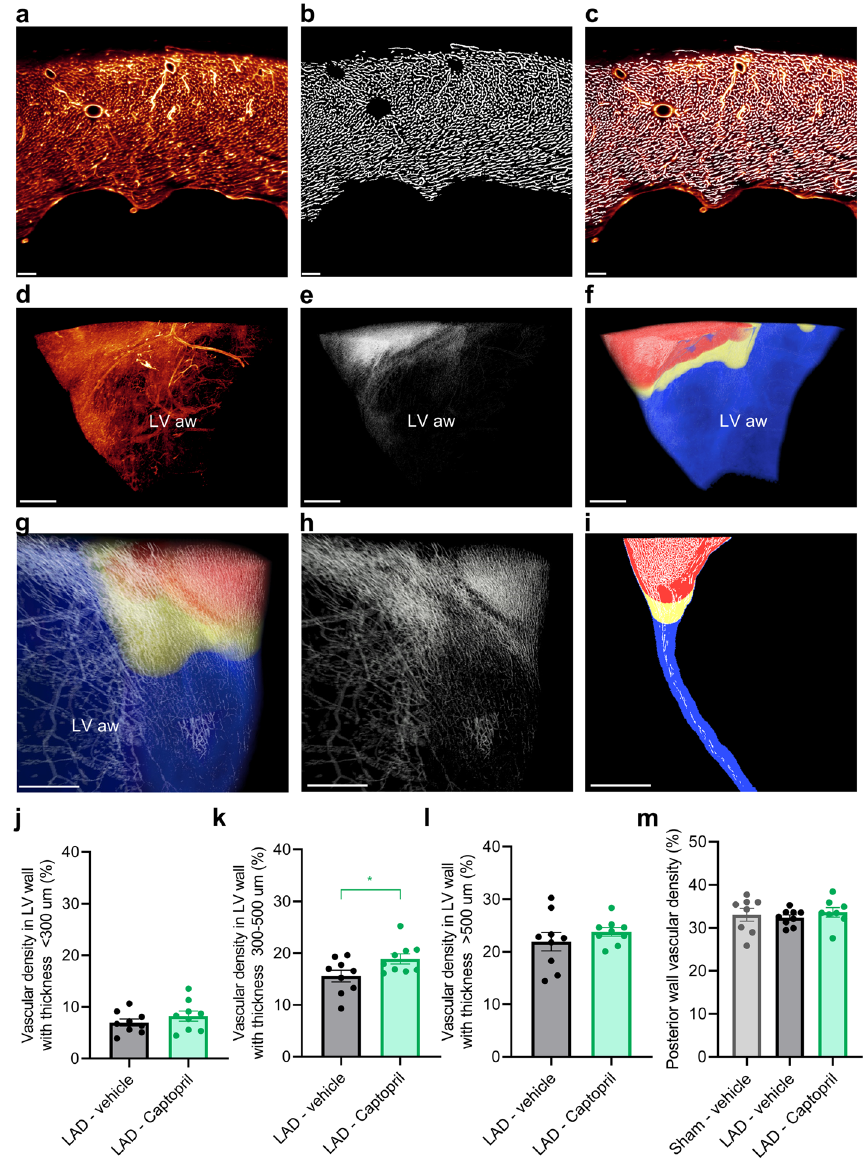
Figure 5. Captopril improves vascularization in the border zone. ( a ) 2D view of lectin perfused vasculature in the left ventricle (LV) wall. ( b ) Automatically segmented blood vessels in the same image. ( c ) Lectin perfused vasculature and overlay with automated detection (in white) of capillaries and arterioles. ( d ) 3D view of lectin perfused vasculature in the LV anterior wall (LV aw, view from the inside of the LV chamber towards the anterior wall). ( e ) Automated analysis of lectin signal in the same 3D image stack. ( f ) Wall thickness map corresponding to the same area. Thicker wall (> 500 µm) is shown in red, border zone with thickness between 300–500 µm in yellow and LV wall with thickness < 300 µm in blue. ( g-h ) Magnified view from the anterior side of LV. ( i ) 2D section through the LV wall, demonstrating wall thickness categories. ( j ) There is no difference in vascular density in the infarct zone (wall thickness < 300 µm) between vehicle and Captopril treated groups. ( k ) Captopril treatment improves vascular density in the border zone with wall thickness 300–500 µm. ( l ) No difference is visible between the groups in cardiac tissue with wall thickness above 500 µm. ( m ) Vascular density in posterior heart wall (no differences were observed between the study groups). One-way ANOVA with Tukey’s post hoc test. Significance: *p < 0.05. Data is presented as mean ± s.e.m., n = 8–9. Scale bars: ( a – c ), 100 µm; ( d – i ), 500 µm. LAD: left anterior descending artery